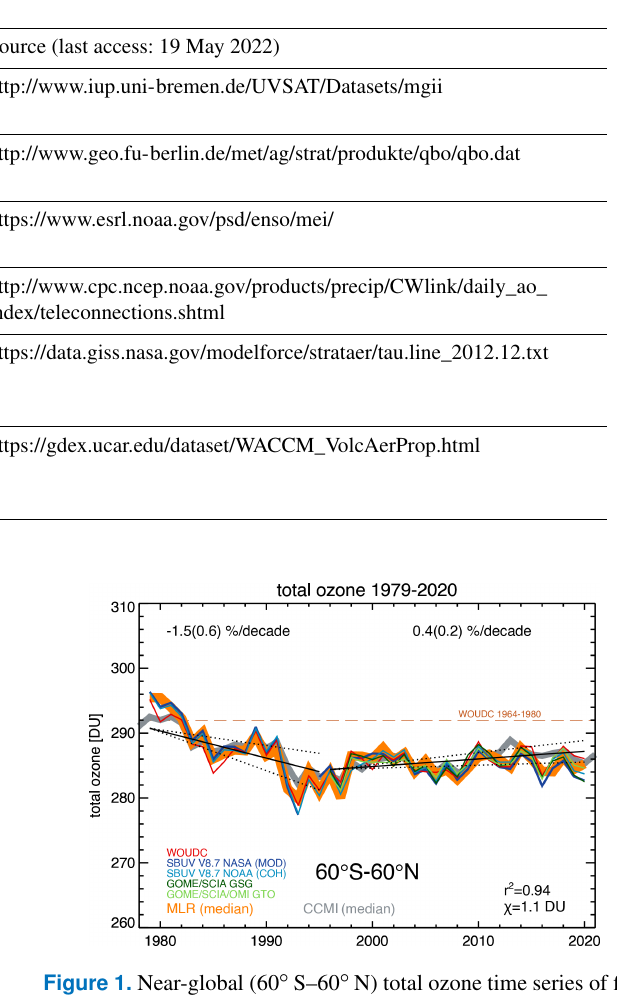
Table 2. Sources of explanatory variables/proxy time series used in the MLR.